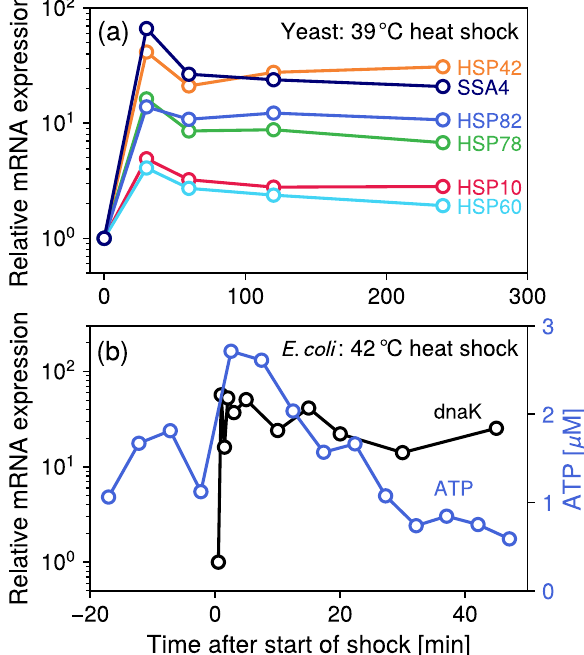
FIG. 7. Experimental results for the heat shock response of yeast and E. coli . (a) Relative mRNA expression of six chaperone genes in S. cerevisiae yeast versus time after the start of a 30 °C → 39 °C heat shock. The genes, listed on the right, all have the Gene Ontology database annotation 0051082 [77,78], in- dicating that their products exhibit chaperone activity (binding to unfolded proteins). (b) The black curve shows the relative mRNA expression of the E. coli chaperone gene dnaK versus time after the start of a 30 °C → 42 °C heat shock [73], with units shown on the left-hand axis. The blue curve shows ATP concentration for the same system, with units shown on the right-hand